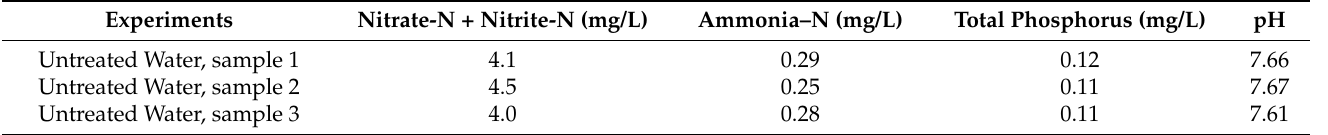
Table 3. Results of fish farm water analyses before field water treatment experiments.